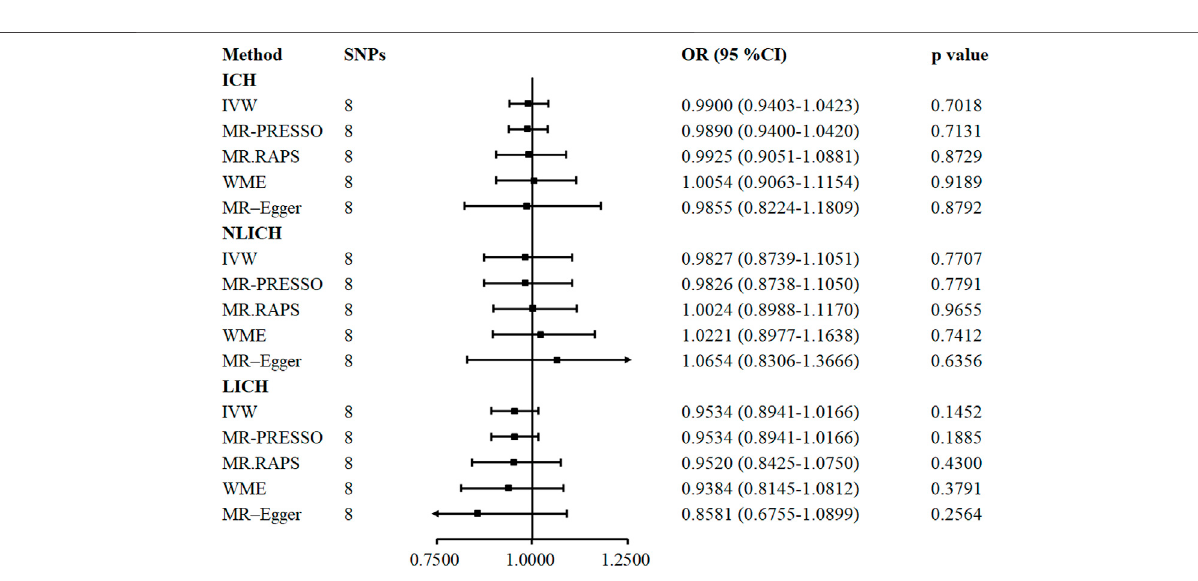
Frontiers in Genetics |